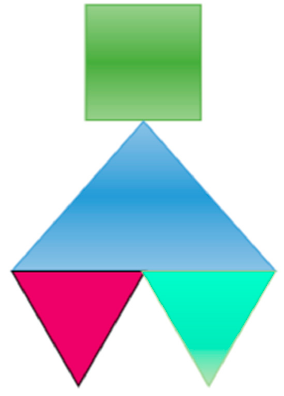
Figure 6. Example of composition of geometric figures for Activity 1.